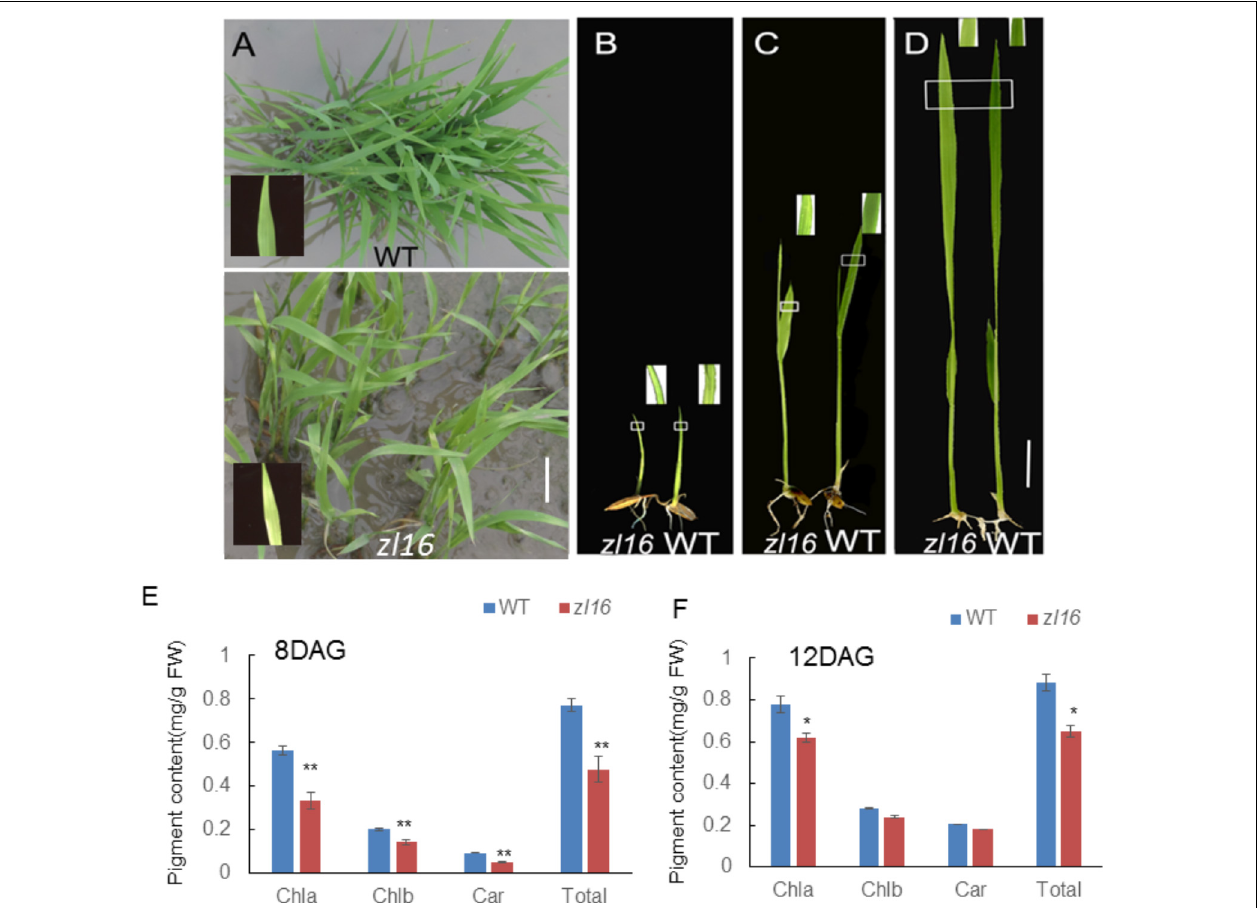
FIGURE 1 | Phenotypic characteristics of zl16 mutant. (A) Phenotypic comparison between the wild type (WT) and zl16 mutant seedlings in the paddy field after 20 days of germination. The inset means enlarged detail of leaf blade. (B–D) The WT and zl16 mutant seedlings in a growth chamber at the 5th- (B) , 8th (C) , and 12th-day after germination, respectively. Bars = 2 cm. The inset indicates enlargement of leaf sector in box. (E–F) Measurement of pigment contents in WT and zl16 mutant seedlings at the 8th (E) and 12th- day (F) after germination (DAG), respectively. Chla, Chlorophyll a; Chlb, Chlorophyll b; Car, total carotenoids; FW, fresh weight. Bar denotes standard error ( SD , n = 6). Asterisks indicate the significance levels according to Student’s t -test: ∗ P < 0.05, ∗∗ P < 0.01.